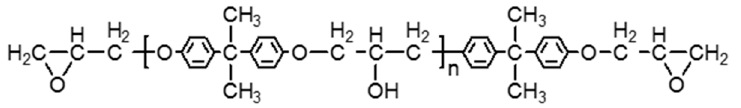
Figure 8. The molecular formula of E44 epoxy resin (bisphenol A).